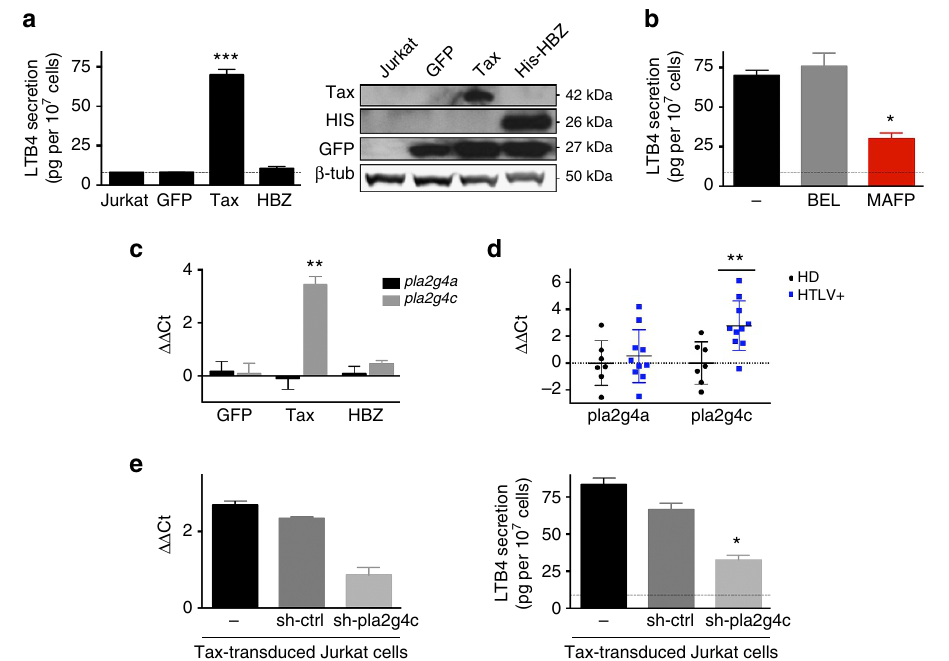
Figure 2 | HTLV-1-induced LTB4 secretion depends on Tax-induced cPLA2 c overexpression. ( a ) Tax-expressing Jurkat cells secrete significant levels of LTB4. Jurkat cells were transduced with lentiviral vectors encoding GFP alone or together with the viral regulatory proteins Tax and HBZ. Protein expression was detected by western blot 48h post transduction (right panel). Spontaneous LTB4 secretion levels were determined by ELISA. P value o 10 (cid:2) 3 ; n ¼ 4; mean ± s.e.m.; ANOVA, Tukey’s post hoc test. ( b ) Tax-induced LTB4 secretion is dependent on group 4 phospholipases A2 (PLA2G4). Tax-expressing Jurkat cells were treated with either 1 m M MAFP or 5 m M BEL for 30min. Spontaneous LTB4 secretion was detected by ELISA. P value ¼ 0.019; n ¼ 4; mean ± s.e.m.; ANOVA, Tukey’s post hoc test. ( c ) Pla2g4c transcript levels are increased in Tax-expressing Jurkat cells. Expression levels of pla2g4a (encoding cPLA2 a ) and pla2g4c (encoding cPLA2 g ) were determined by RT–qPCR on Jurkat cells transduced with GFP, Tax or HBZ. mRNA levels were normalized to gapdh expression and gene expression in Jurkat cells. P value ¼ 2.10 (cid:2) 3 ; n ¼ 3; mean ± s.e.m.; ANOVA test, Tukey’s post hoc test. ( d ) Pla2g4c mRNA levels are higher on CD4 Tcells from HTLV-1-infected individuals when compared to HDs. CD4 Tcells from HDs ( n ¼ 7), HACs ( n ¼ 5) and HAM/ TSP ( n ¼ 5) were isolated by negative selection. RT–qPCR for pla2g4a and pla2g4c was performed. Values were normalized to gapdh expression and the mean value on CD4 Tcells from HDs. P value ¼ 0.007; mean ± s.e.m.; Mann–Whitney U -test. ( e ) Pla2g4c KD counters Tax-induced LTB4 secretion. Jurkat cells were transduced with vectors encoding a shRNA-targeting pla2g4c (or a control sh-ctrl). Cells were then transduced with Tax. KD efficiency was determined by RT–qPCR (normalized to gapdh expression and pla2g4c in Jurkat cells) (left panel). LTB4 secretion was detected by ELISA. P value ¼ 0.03; n ¼ 3; mean ± s.e.m.; Friedman test, Dunn’s post hoc test. Tax activates pla2g4c transcription through NF- j B and CREB . secretion of LTB4 (Fig. 2e, right panel), confirming the implication of cPLA2 g . The pla2g4c promoter was cloned into a luciferase reporter Overall, these findings demonstrate that, on HTLV-1 infection plasmid. Transfection of the reporter plasmid together with a and Tax expression, cPLA2 g is overexpressed, leading to LTB4 plasmid encoding Tax confirmed that the viral transactivator secretion. activates pla2g4c transcription (Fig. 3a). NATURE COMMUNICATIONS|8:15890|DOI: